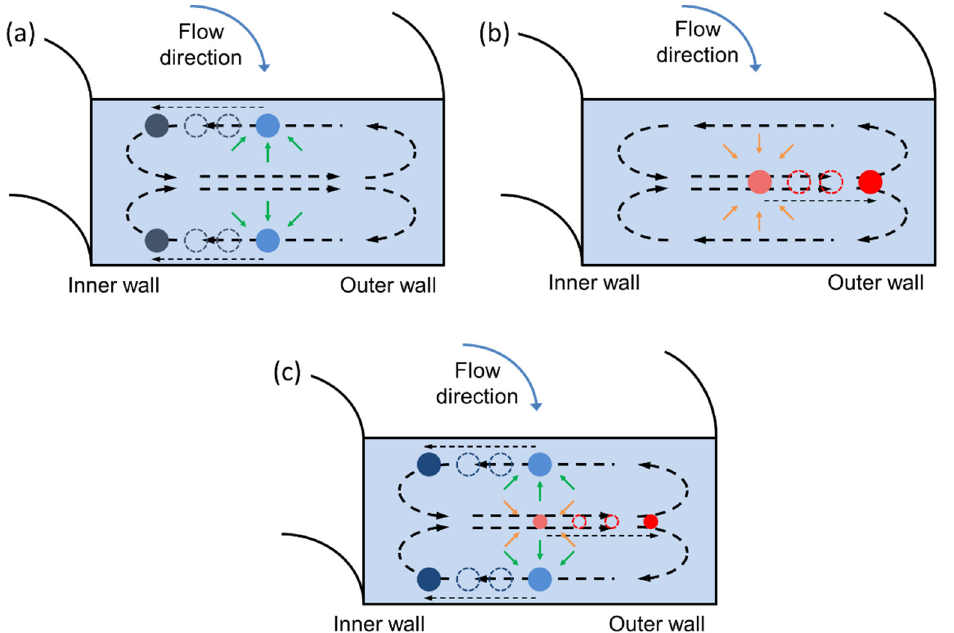
Figure 1. Representation of particle focusing in curved microfluidic channels. ( a ) In Newtonian fluids, particles are driven towards the inner wall. ( b ) In the viscoelastic regime, particles are driven towards the outer wall. ( c ) In the intermediate regime, size-based separations can be achieved.